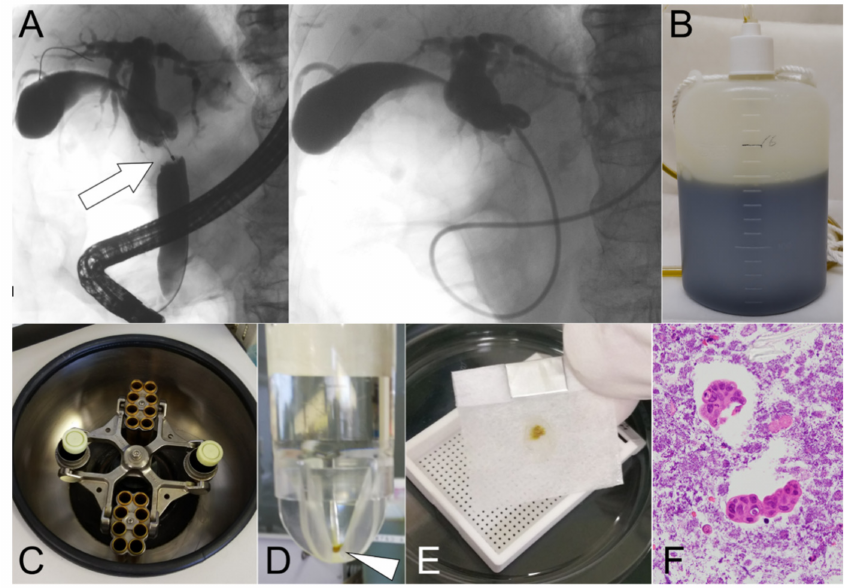
Figure 2. The cell block method was performed using overnight-stored bile. ( A ) Suspicious malignant biliary stricture (MBS) was detected in the middle bile duct (arrow). Endoscopic nasobiliary drainage (ENBD) tube was placed in the occluded bile duct. ( B ) Bile from the ENBD tube was stored overnight after ENBD tube placement. ( C ) The stored bile was processed by centrifugation for 10 min. ( D ) Only the precipitate (arrowhead) was collected and fixed in 10% neutral buffered formalin. ( E ) The precipitate was then embedded in paraffin wax. ( F ) The malignant specimen could be detected by hematoxylin and eosin staining of the